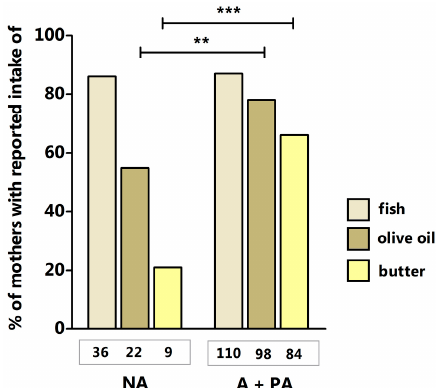
Figure 1. Prevalence of prenatal consumption of fish, olive oil, and butter in non-anthroposophic (NA), anthroposophic, or partially anthroposophic mothers (A + PA). Numbers of mothers with complete data on dietary exposures are presented below the bars. Fisher exact test: ** p = 0.007; *** p < 0.001.